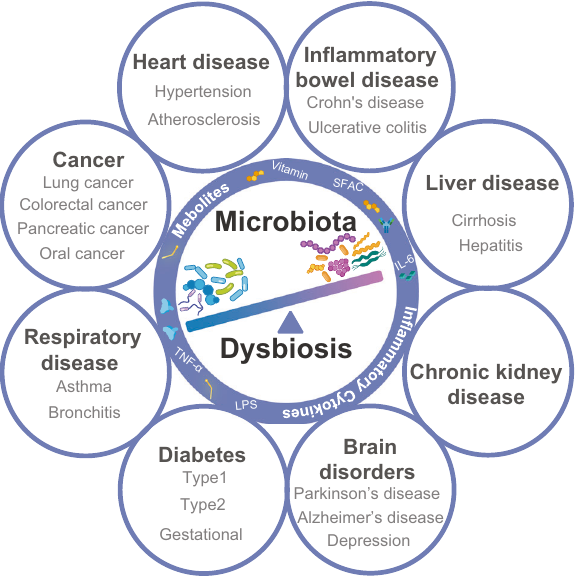
Fig. 4 Human microbiota dysbiosis contributes to various